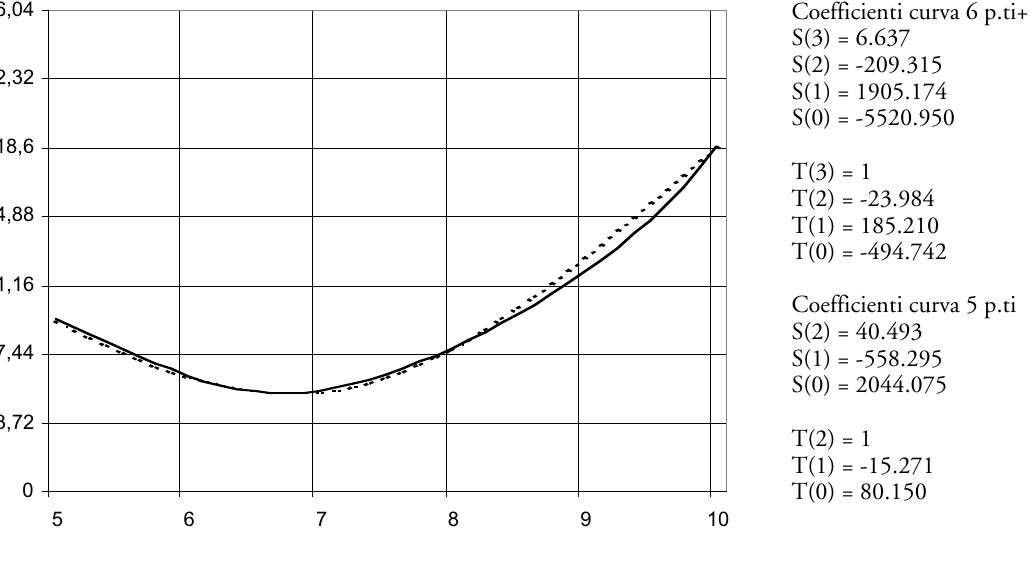
il 17-1-97 in MI 2